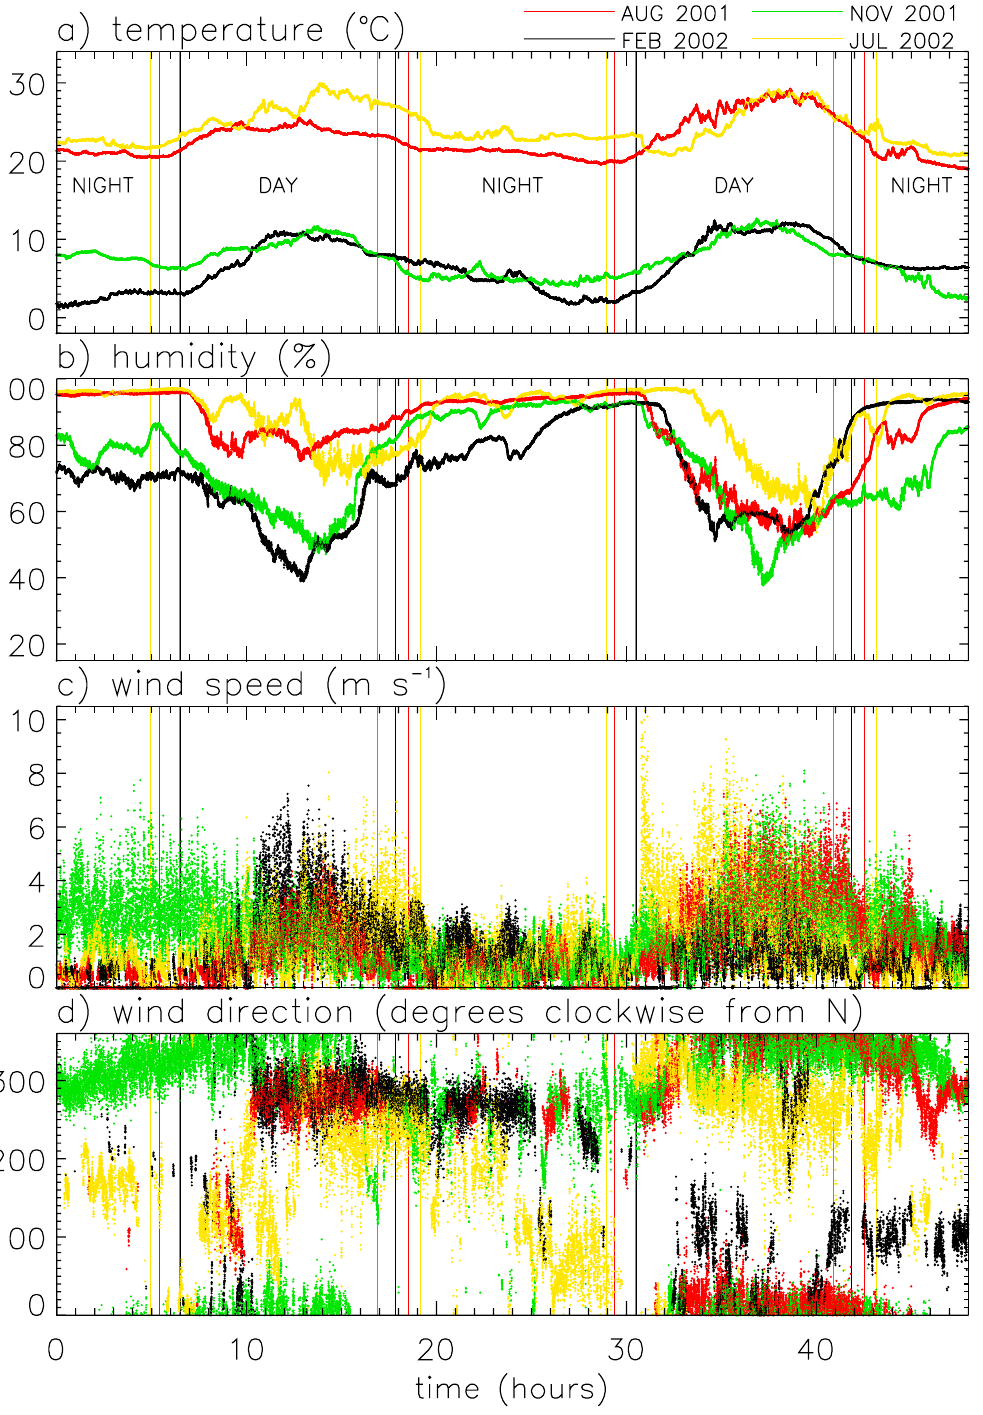
Fig. 3. Surface weather at the MU radar site, for four 2-day periods containing the four case studies in Table 1. Each dot is a 5-s time average. Vertical lines show sunrise and sunset